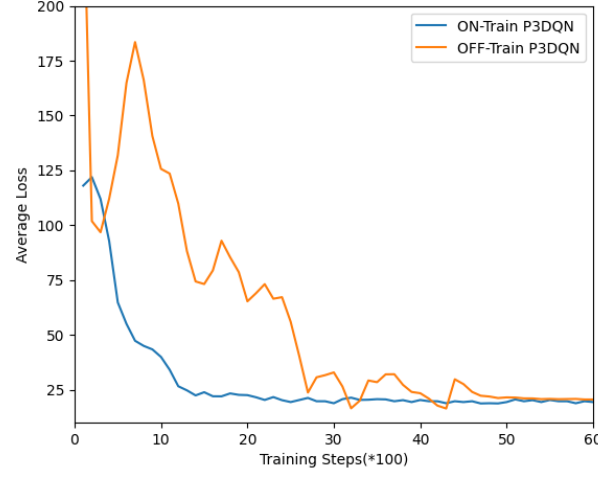
Figure 5. Loss with the training steps.